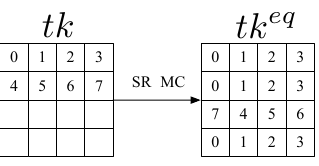
Figure 4: Reordering of ART , SR and MC operations in a